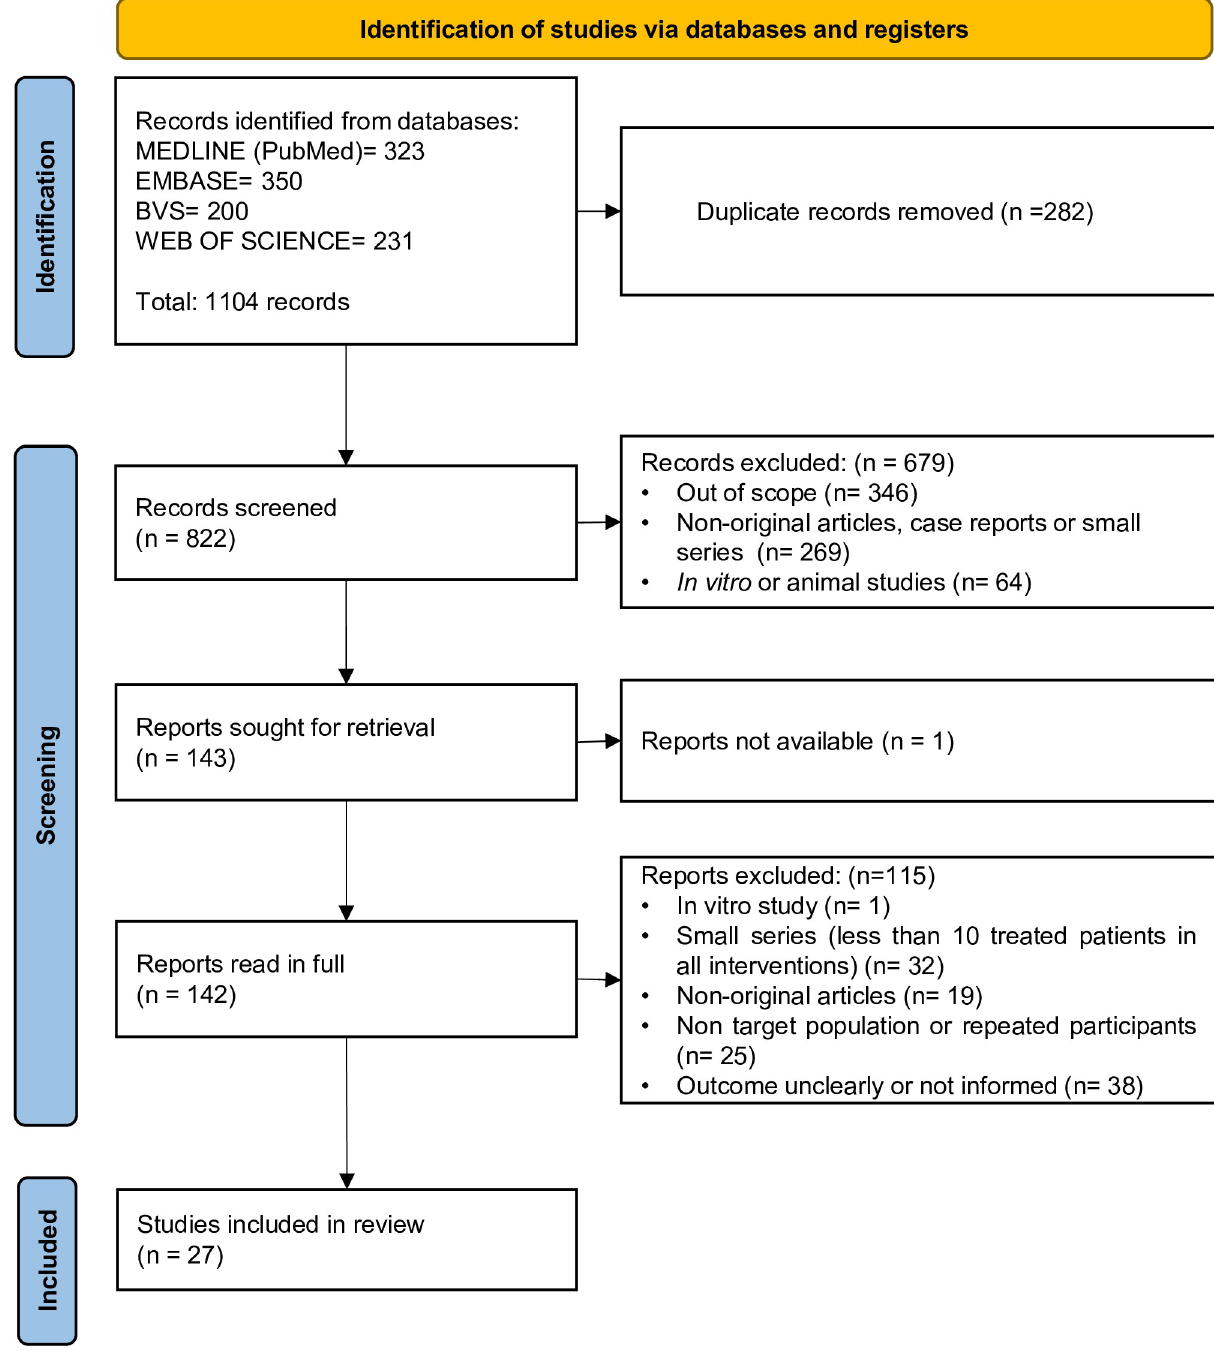
Fig 1. PRISMA flow diagram of the study selection